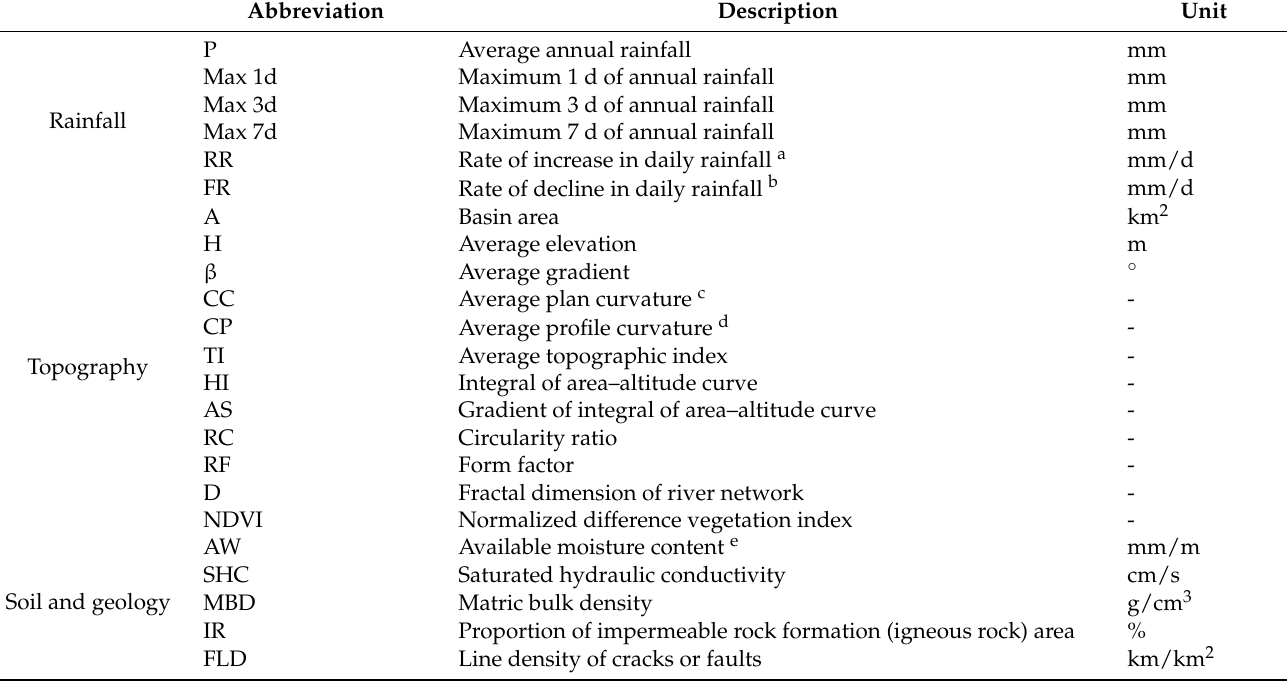
Table 1. Description of the 23 basin